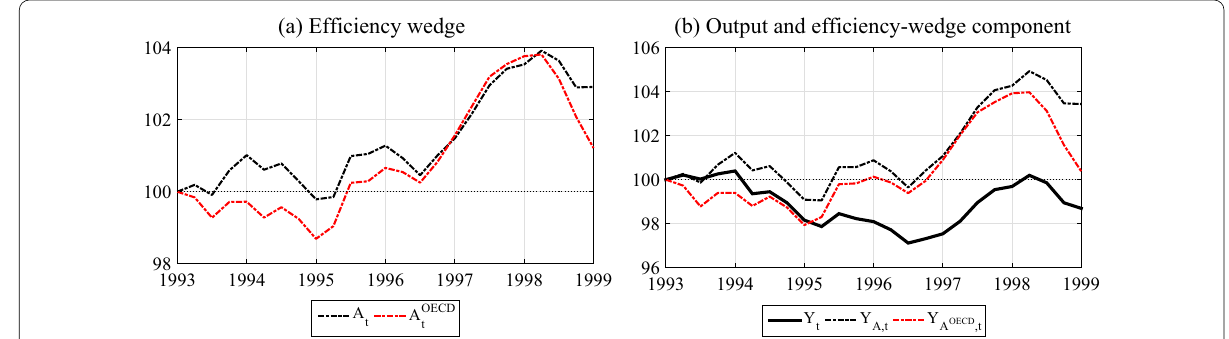
Fig. 8 Hours mismeasurement and productivity. A t and A OECD t denote the measured efficiency wedge based on the SNB and OECD series of hours worked. Y t denotes output, and Y A , t and Y A OECD , t are the efficiency-wedge components of output based on the SNB and OECD data for hours